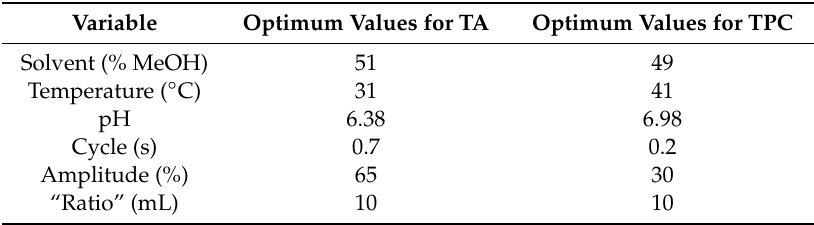
Table 2. Optimum conditions for TA and TPC by